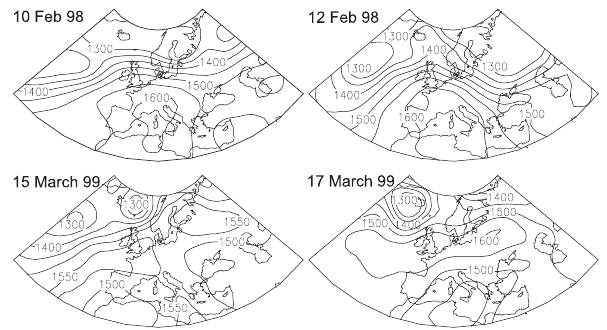
Fig. 2. 850 hPa geopotential height field over Europe on 10 and 12 February 1998 (top) and 15 and 17 March 1999 (bottom), at 12 UTC. Contour lines are in units of geopotential